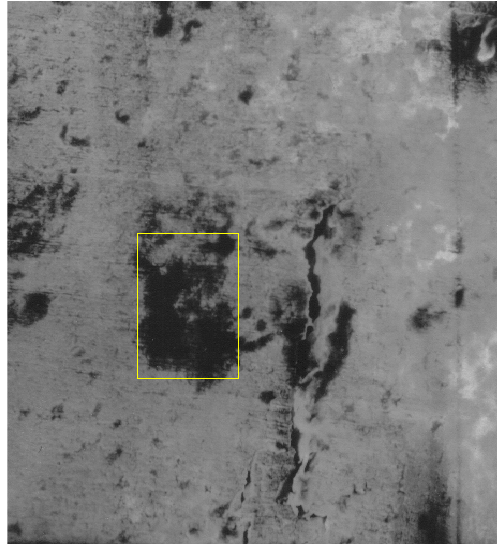
Figure 4. The selection of the modified area.